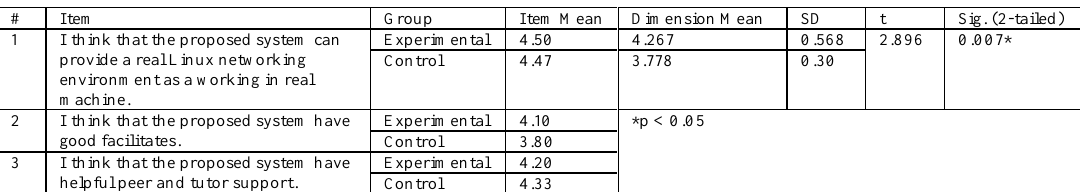
Table 1 System Characteristics of NVBLab.